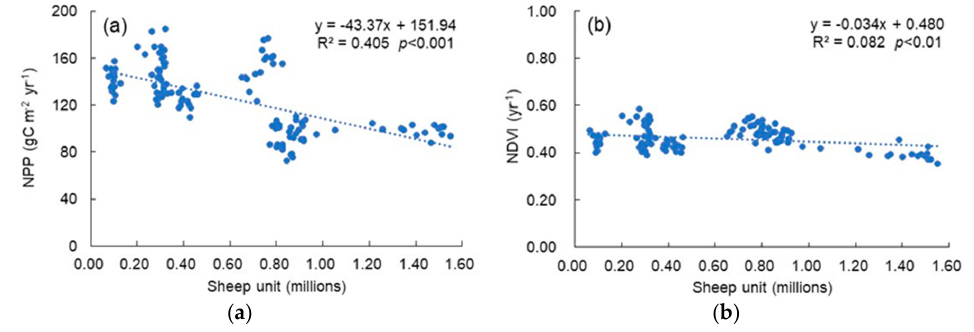
Figure 8. The correlation between the sheep unit and vegetation growth: ( a ) NPP and ( b )